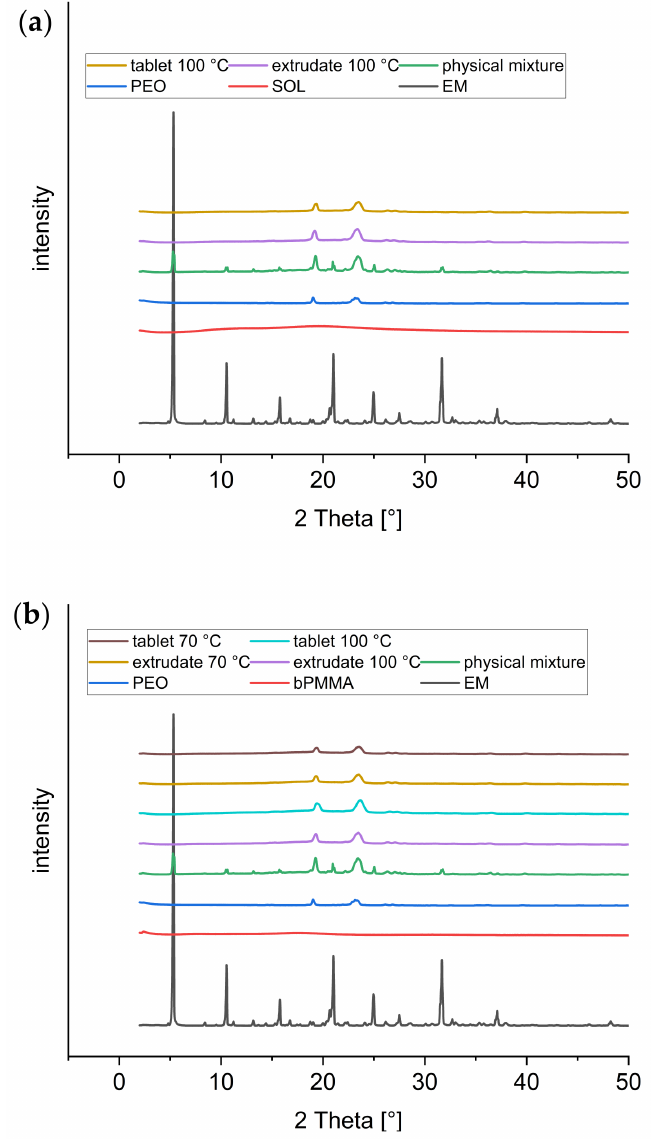
Figure 4. X-ray diffractograms of the formulation containing SOL extruded at 100 ◦ C ( a ) and the formulation containing bPMMA extruded at 100 ◦ C and 70 ◦ C ( b ),